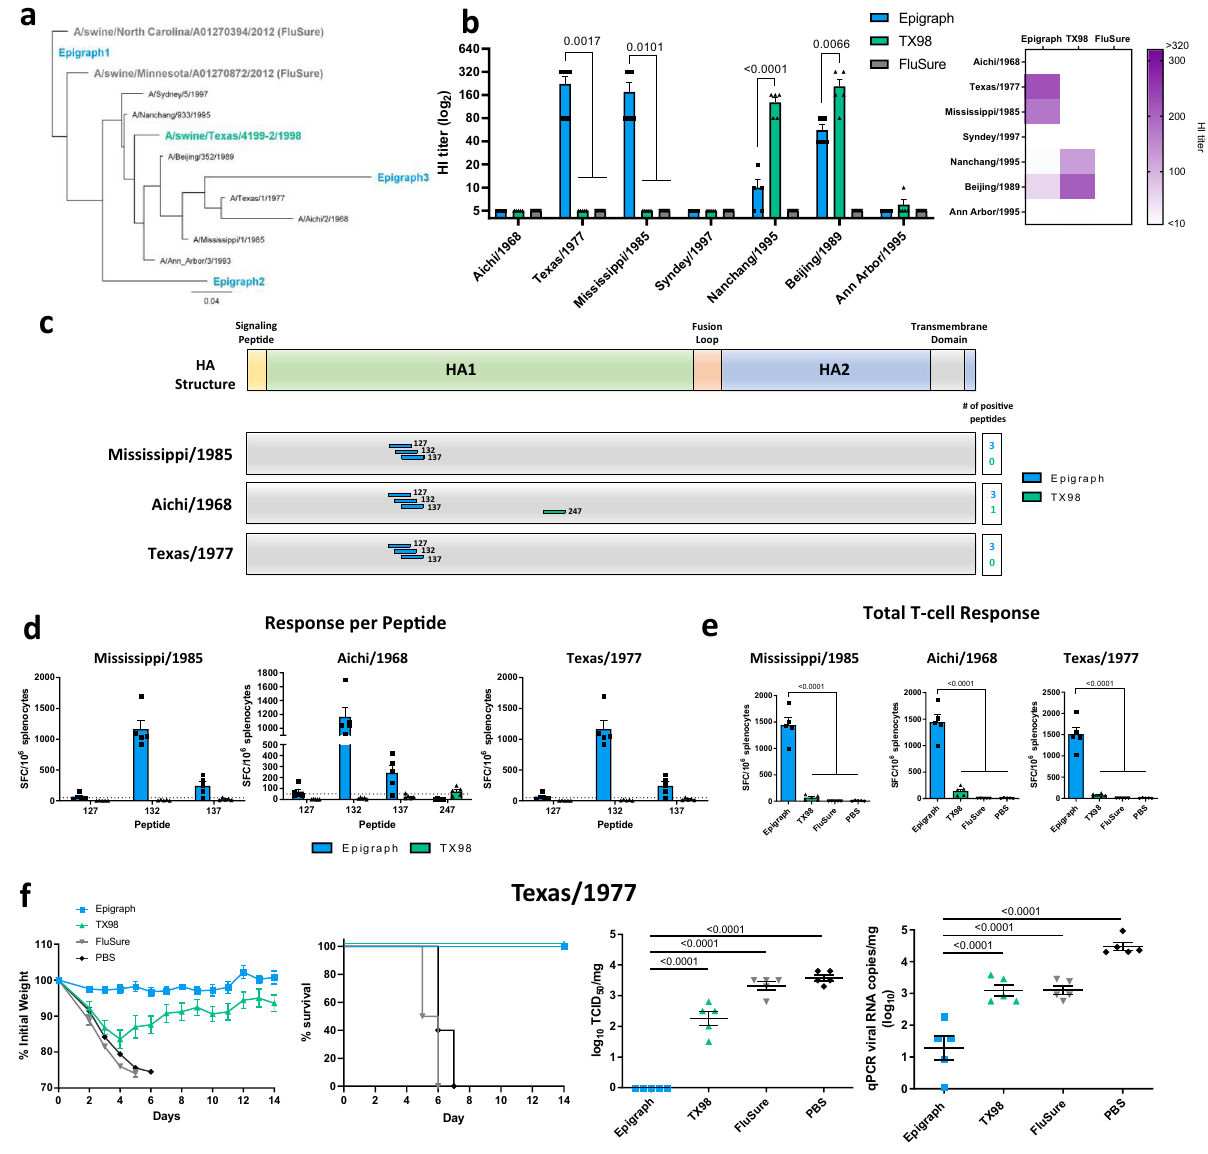
Fig. 5 Cross-reactive immune correlates and protection to human H3 isolates. (To determine the cross-reactive immune responses of the swH3 vaccines to huH3 isolates, a panel of 7 representative huH3 strains were selected. A maximum likelihood phylogenetic tree was constructed to visualize the relationship of these huH3 assay strains with the swH3 vaccine immunogens ( a ). An HI titer was performed against these huH3 strains with sera from BALB/c mice vaccinated in Fig. 2 ( n = 5; one-way ANOVA with Tukey ’ s multiple comparisons compared to the epigraph group) ( b ). A heat map of these HI titers was constructed to further visualize the total cross-reactive antibody response of each vaccine. Splenocytes isolated from vaccinated mice were also examined for cross-reactive cellular immune responses to three huH3 strains using an IFN γ ELISpot. T-cell epitopes against the Mississippi/1985, Aichi/1986, and Texas/1977 strains were mapped using an overlapping peptide array. Peptide responses >50 spot-forming cells (SFC) per million were considered positive. Positive peptides for each vaccine and their relative location on the HA protein are indicated ( c ). The peptide number designates the position of the last amino acid in the peptide on the total HA protein. The level of response seen against each positive peptide is reported as SFC per million splenocytes with the dotted line indicating the 50 SFC/million cutoff ( d ). The total T-cell response to each virus peptide array is shown for all vaccination groups ( n = 5; one-way ANOVA with Tukey ’ s multiple comparisons) ( e ). BALB/c mice ( n = 10) were vaccinated with 10 10 vp of HAdV-5-epigraph or HAdV-5-TX98, the commercial inactivated vaccine FluSure, or a sham PBS vaccine and then challenged 3 weeks later with 10 4.3 TCID 50 of Texas/1977 ( f ). Mice were monitored for weight loss and sacri fi ced humanely when 25% weight loss was reached. Five mice per group were sacri fi ced on day 3 post infection to examine lung viral titer by TCID 50 and qPCR ( n = 5; one-way ANOVA with Tukey ’ s multiple comparisons compared to the epigraph group). Data are presented as the mean with standard error